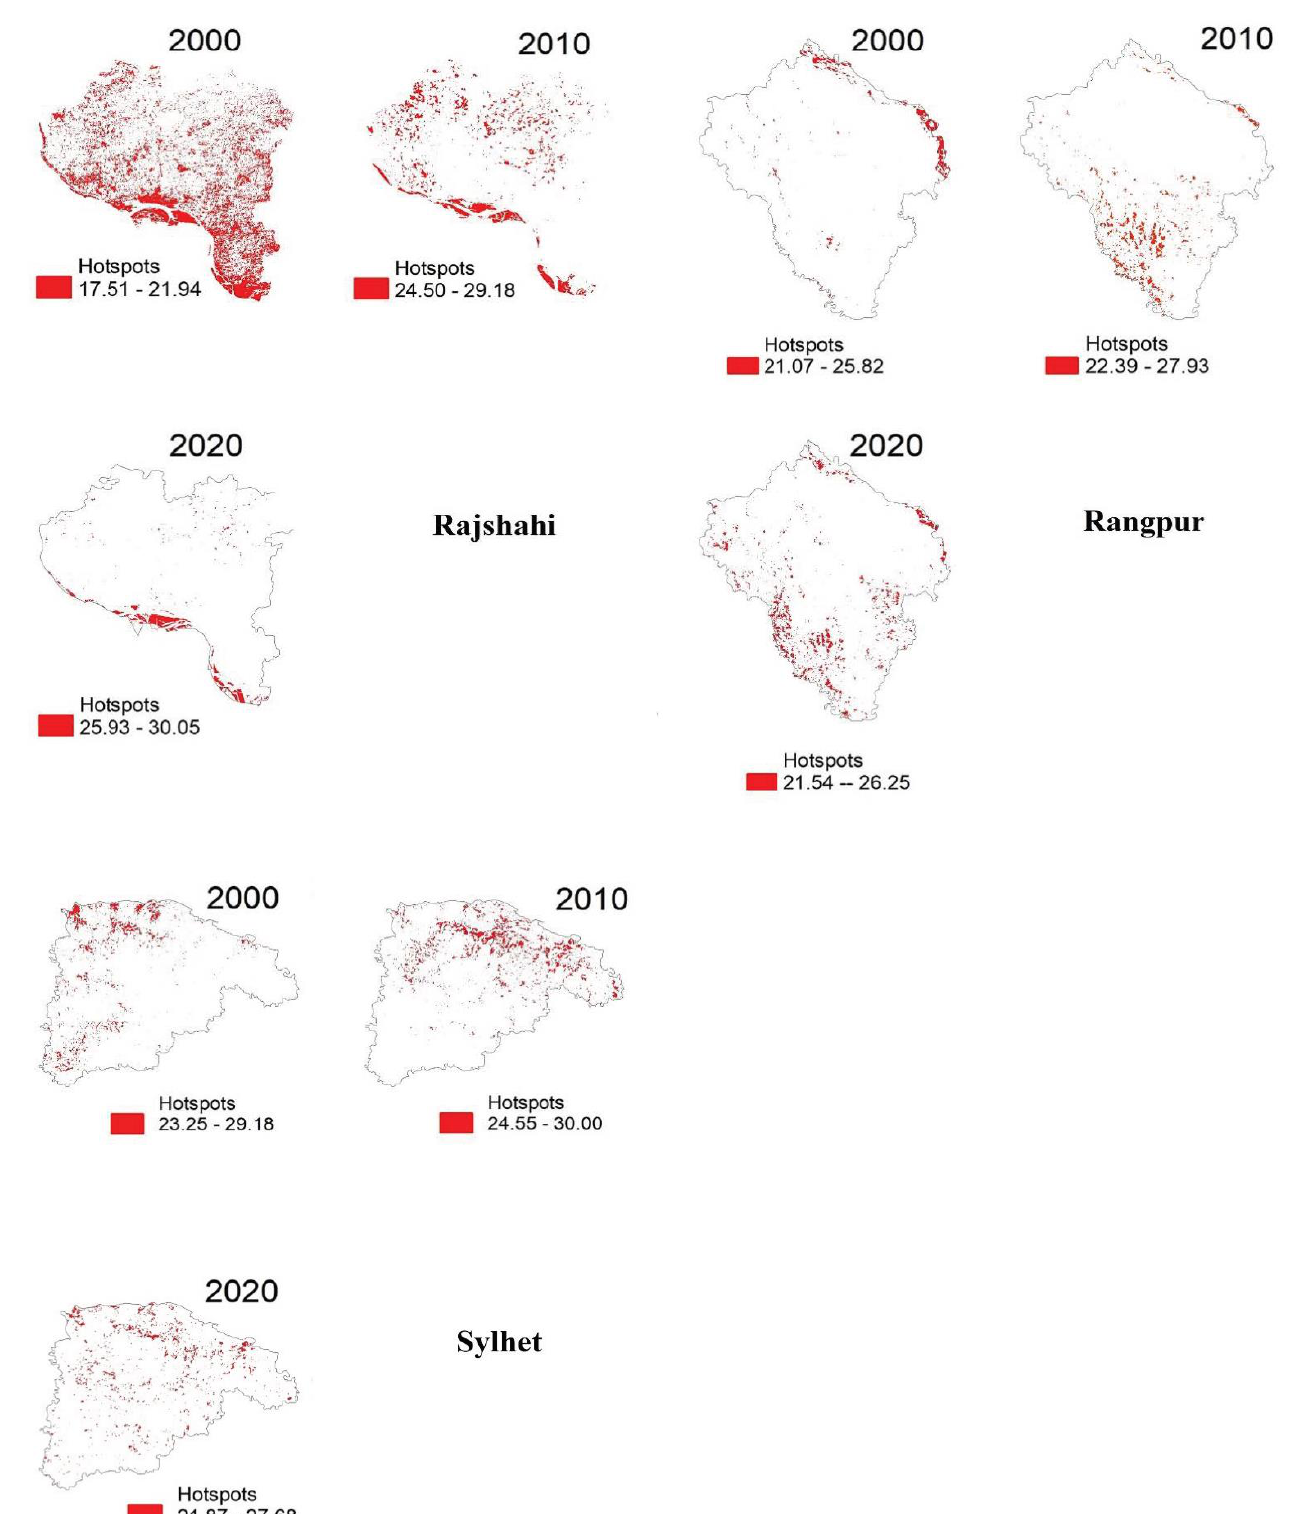
Figure 7. Identified hotspots for seven major districts of Bangladesh during 2000 – 2020. In contrast to the other six districts of Bangladesh, Rajshahi, which experienced less urban expansion (Table 3), showed LST hotspots of 2.47% area, while gradual temperature improvement was noticed from 2000 to 2020, whereas 2010 was found to be stretched for